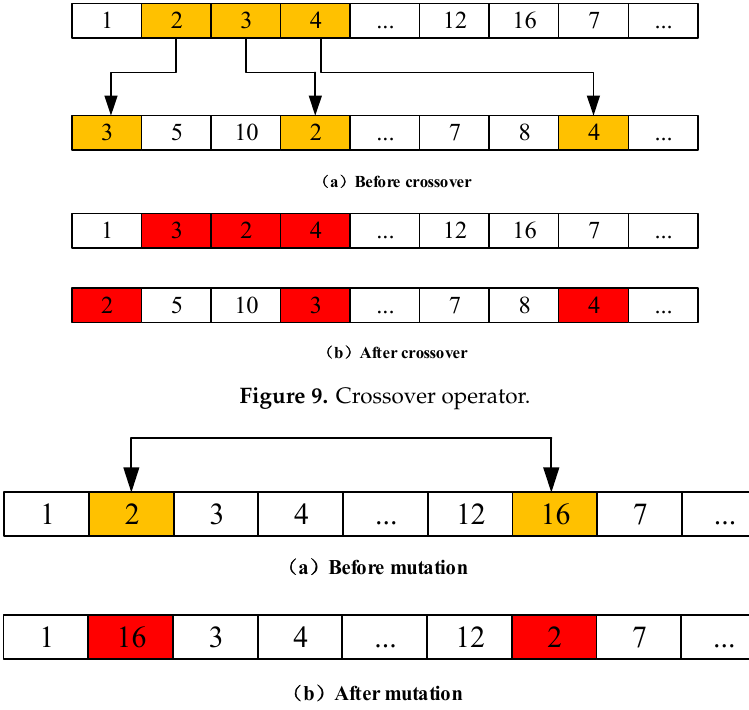
Figure 10. Mutation Figure 10 . Mutation operator. Figure 10 . Mutation operator.